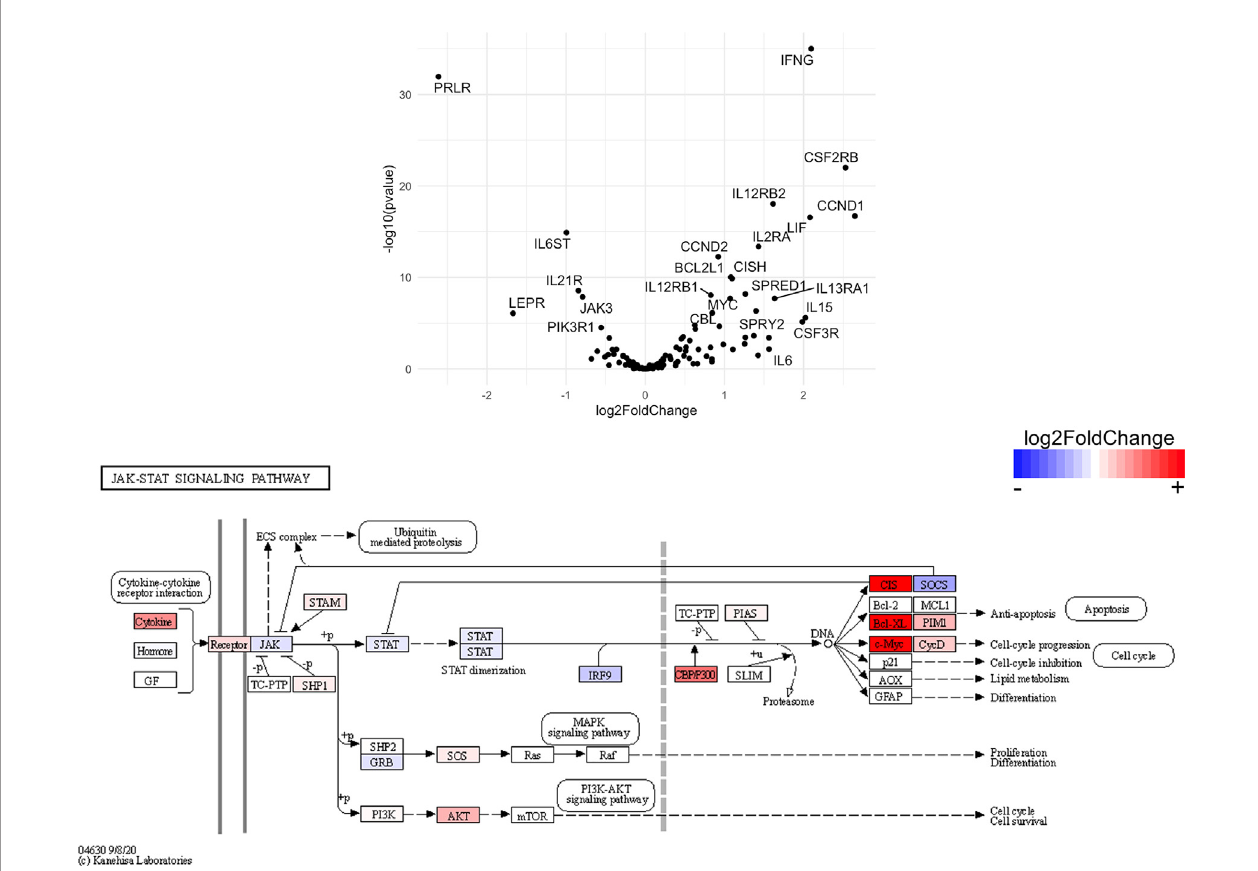
FIGURE 12 | Genes related to JAK/STAT signaling are enriched in CD4 + T cells from the CNS of microglia-de fi cient B6J mice compared to microglia-de fi cient SJL mice. C57BL/6J and SJL/J mice were treated with a PLX5622-supplemented diet seven days prior to i.c. TMEV infection and sacri fi ced at 6 DPI for analysis (n = 10 mice per group). Volcano plot of RNA-seq transcriptome data and KEGG map display JAK/STAT signaling-related gene expression in enriched CD4 + T cells from the CNS of microglia-de fi cient C57BL/6J mice relative to microglia-de fi cient SJL/J